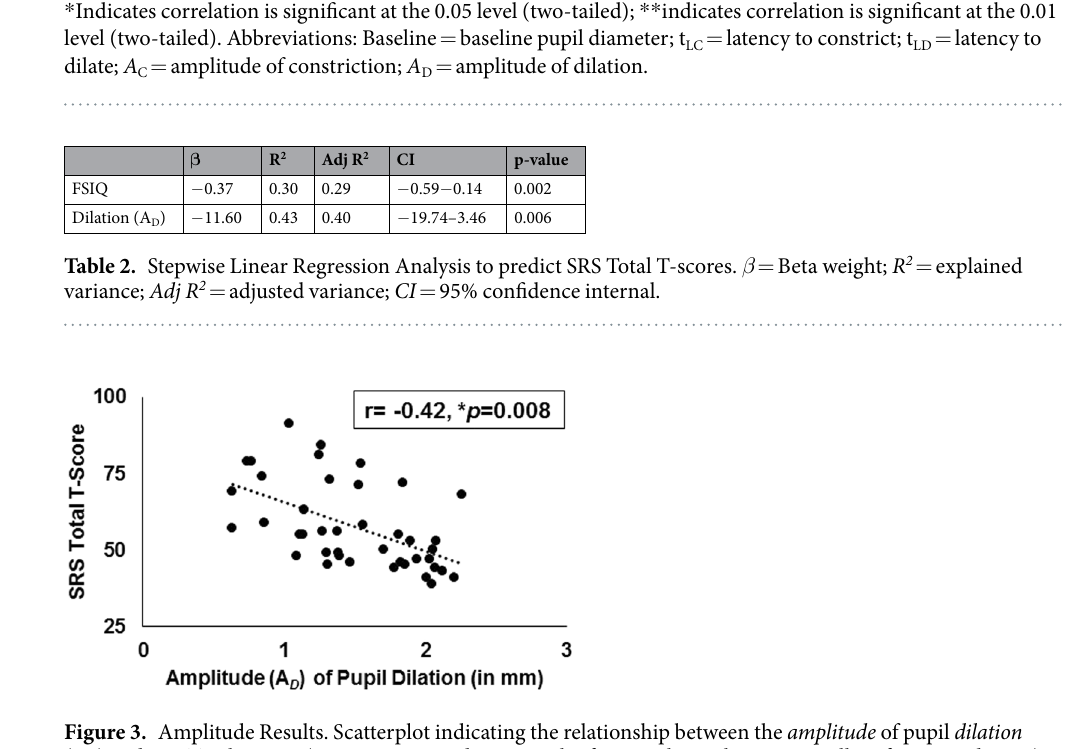
Figure 3. Amplitude Results. Scatterplot indicating the relationship between the amplitude of pupil dilation ( A D ) and SRS Total t-score (statistics reported are a result of a partial correlation controlling for age and